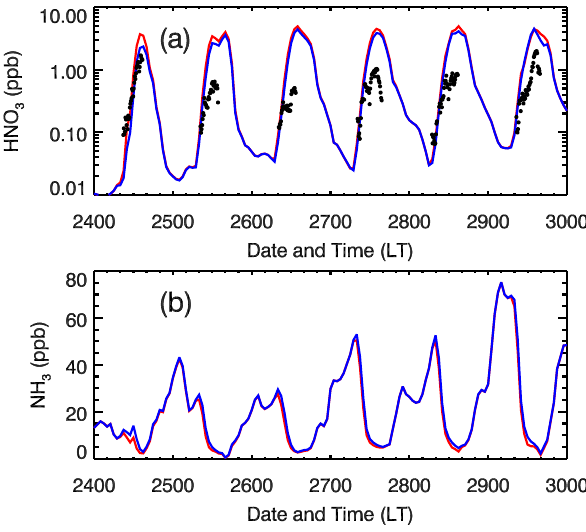
Fig. 12. Same as Fig. 8, except for submicron (a) nitrate and (b) ammonium aerosols.